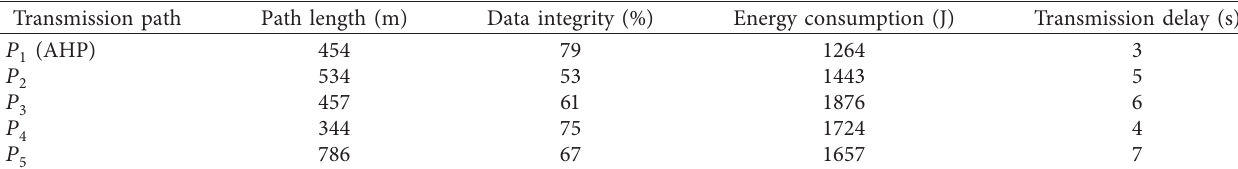
Figure 2: Nodes Table 3: Parameters of each path.